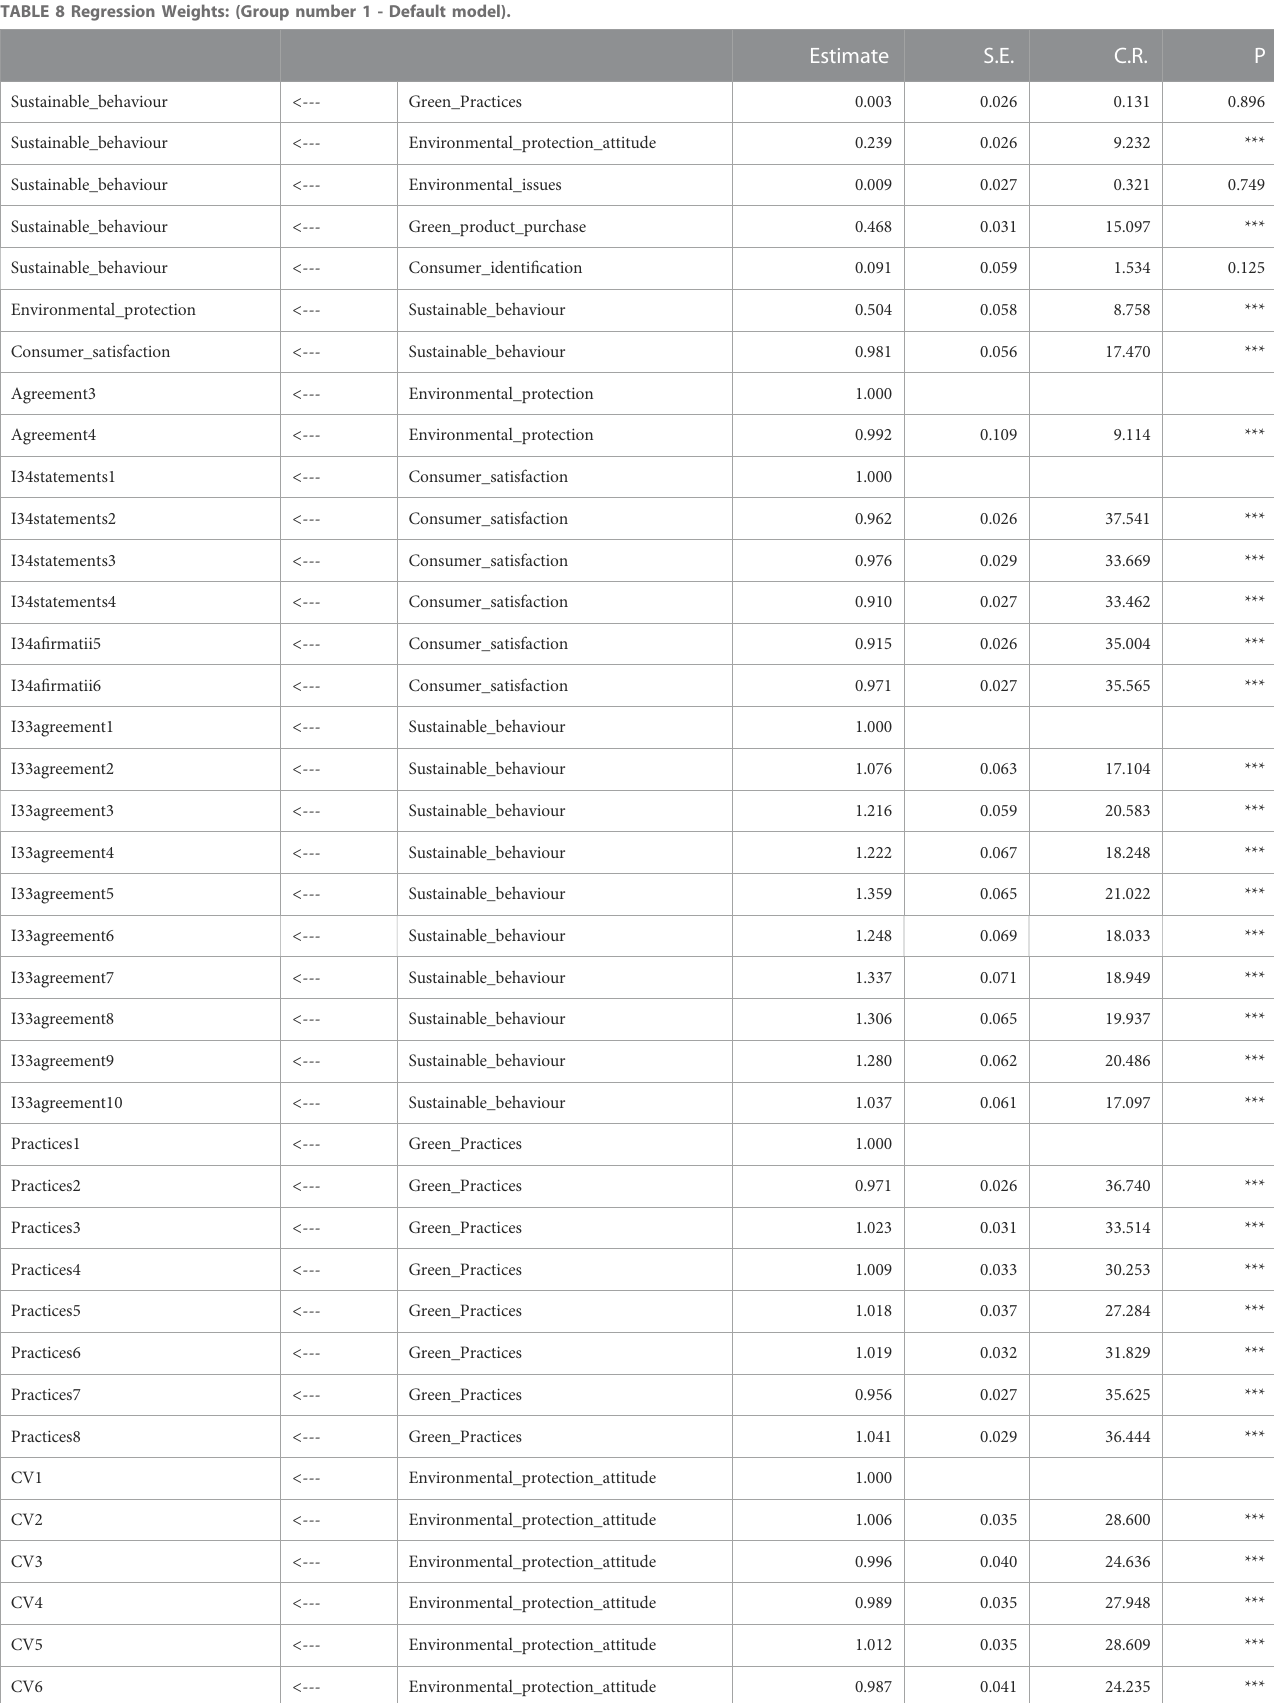
TABLE 8 Regression Weights: (Group number 1 - Default model).